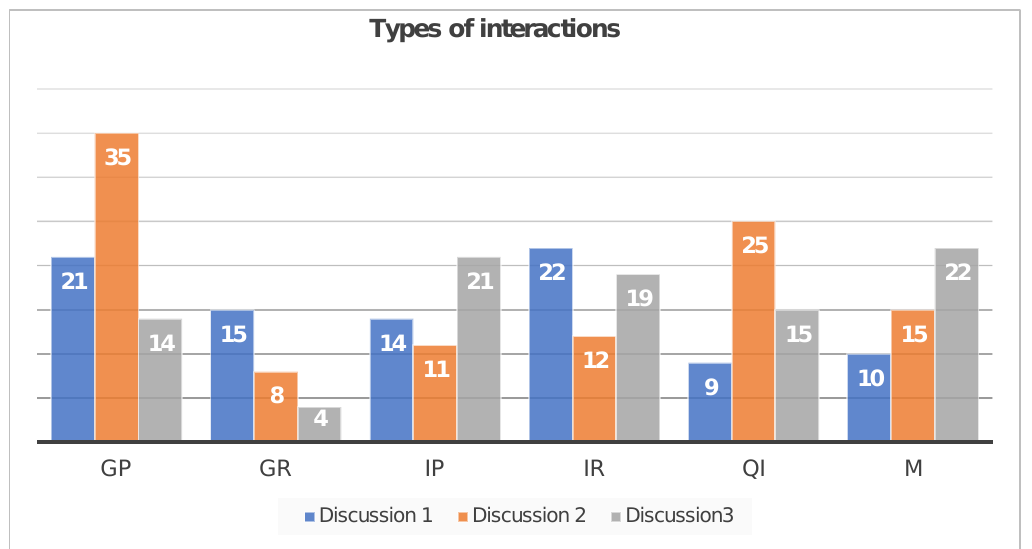
Figure 3. Types of interactions in